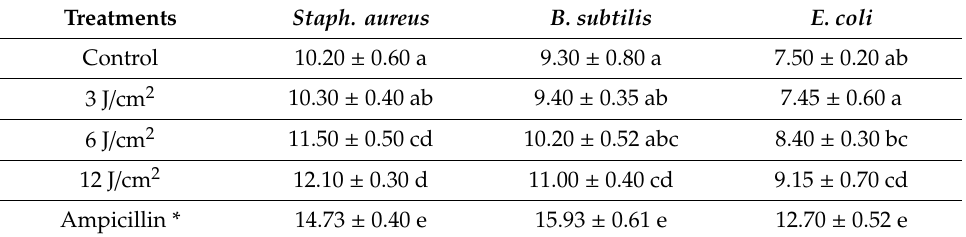
Table 2. Effect of red laser beam on antibacterial activity (diameter of inhibition zone) by L . casei. Treatments